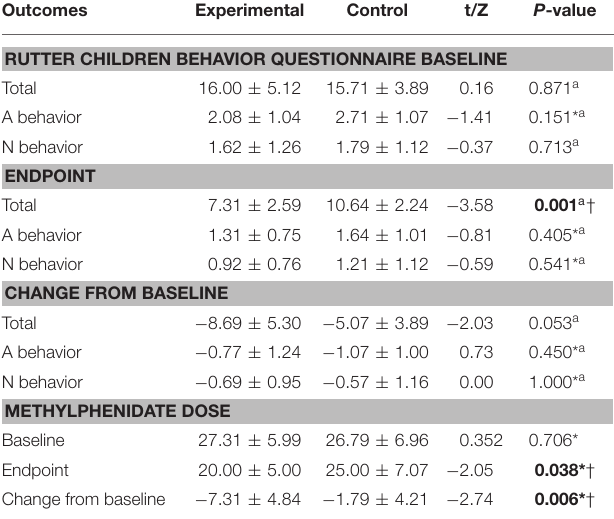
ADHD-RS-IV, Attention Deficit Hyperactivity Disorder Rating Scale-IV. * Two-sample Mann-Whitney Test. a The adjusted critical level of significance using Bonferroni’s correction. † significant. Bold means statistically